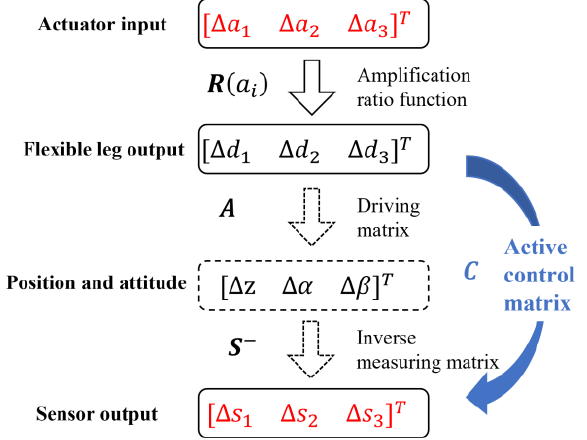
Figure 8. The relationship between actuator input and sensor output.